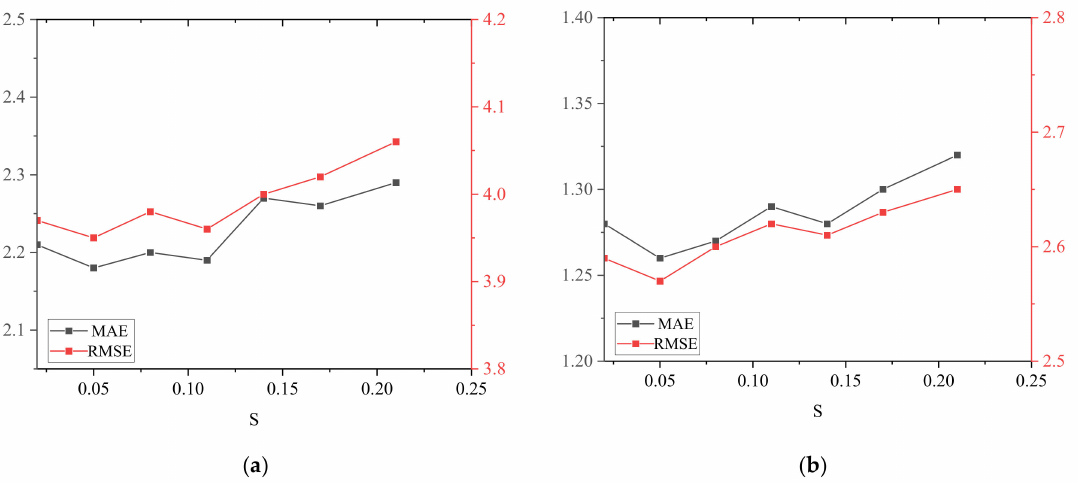
Figure 5. Curves of MAE and RMSE of PEMS-BAY( a ) and PEMSD7(M) ( b ) datasets as a function of scale factor